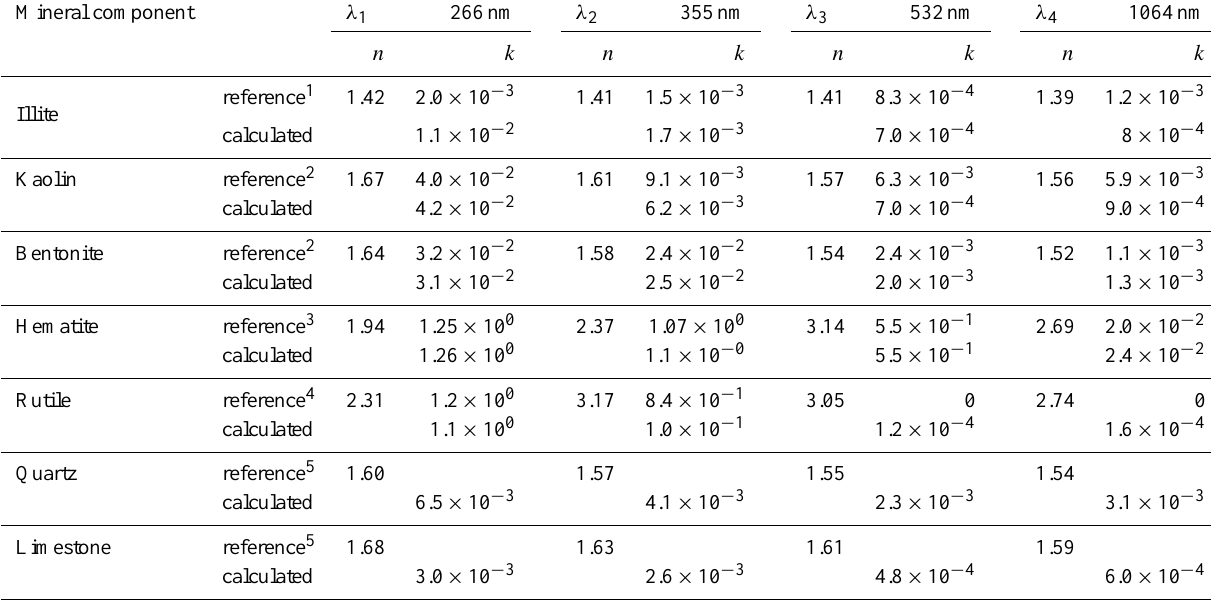
Table 2. Imaginary parts of the complex refractive indices ( κ ) of the measured MD components. For the sake of clarity these data are supplemented with the n and κ values taken from the literature, where the former ones are used in the κ calculation while the latter ones are shown in this table for inter-comparison